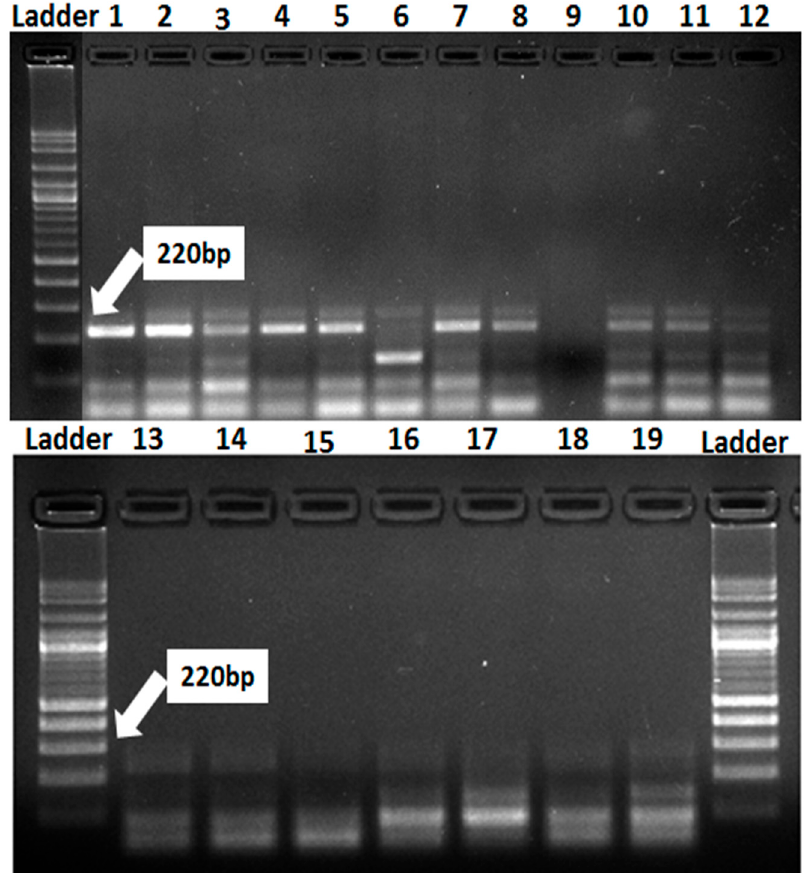
Figure 4. Electrophoretic amplified pattern of DNA extracted from 19 wheat genotypes using the specific primer for Lr34/Yr18 . Lane 1 = Misr-3, Lane 2 = Misr-4, Lane 3 = Misr-2, Lane 4 = Misr-1, Lane 5 = Sids-13, Lane 6 = Gemmeiza-9, Lane 7 = Gemmeiza-12, Lane 8 = Sakha-94, Lane 9 = Sakha-95, Lane 10 = Giza-168, Lane 11 = Gia-171, Lane 12 = Giza-139, Lane 13 = Sids-12, Lane 14 = Sakha-61, Lane 15 = Sids-14, Lane 16 = Gemmeiza-5, Lane 17 = Gemmeiza-7, Lane 18 = Gemmeiza-10, and Lane 19 = Shandweel-1.